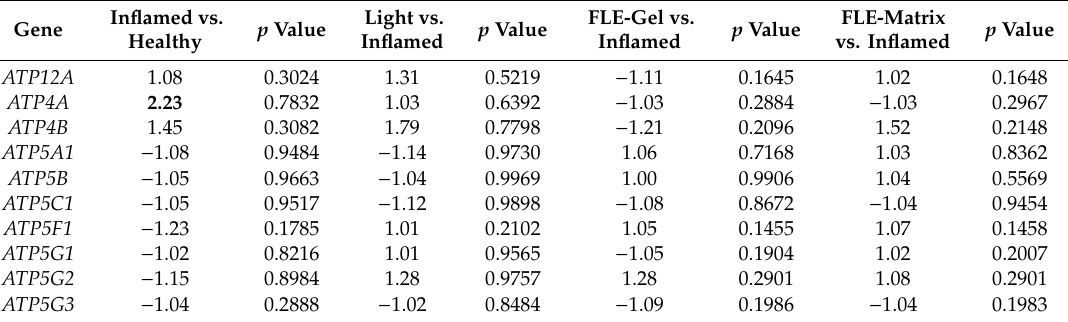
Table 1. Human Mitochondrial Energy Metabolism PCR array.